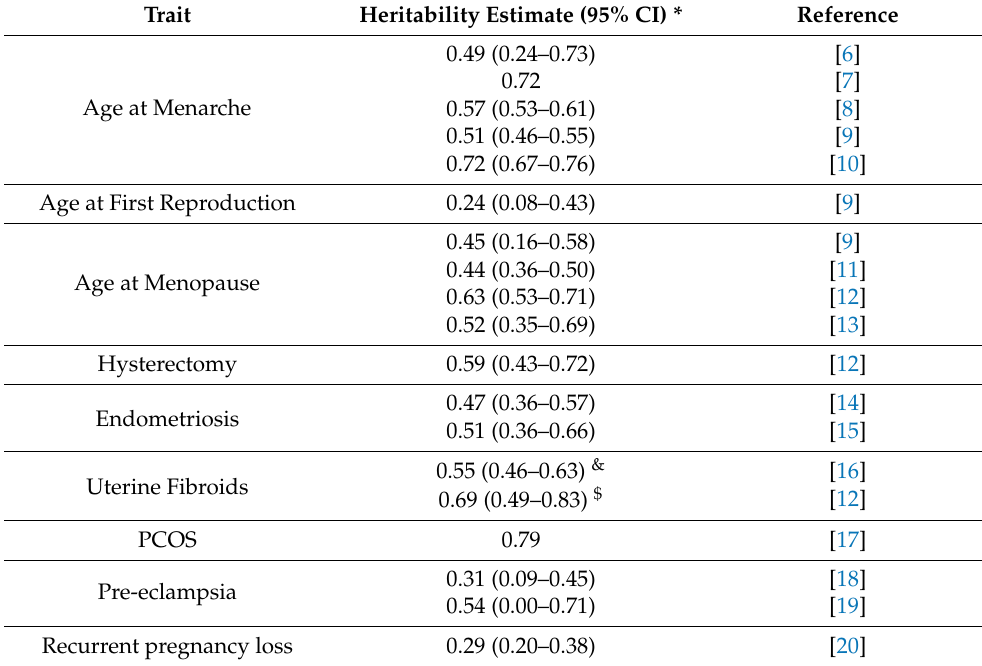
Table 1. Estimates of heritability and 95% confidence intervals * for traits and diseases affecting reproductive lifespan and reproductive